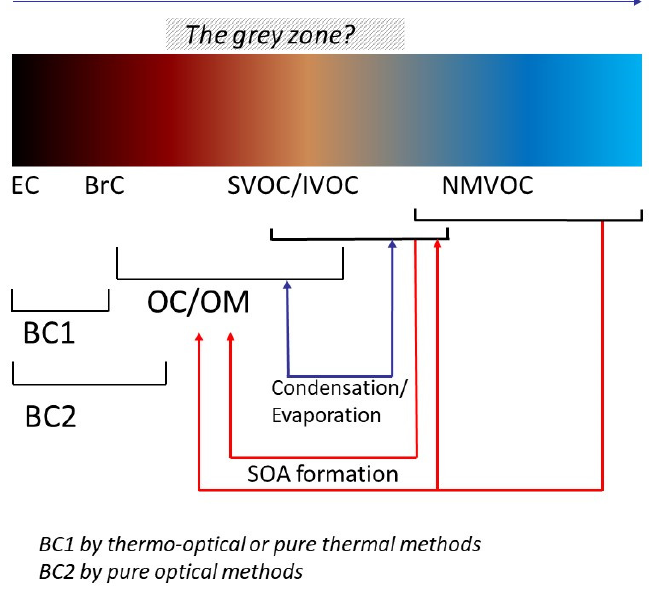
Figure 11. Synoptic description of the carbonaceous species from graphitic carbon (EC) to NMVOCs.